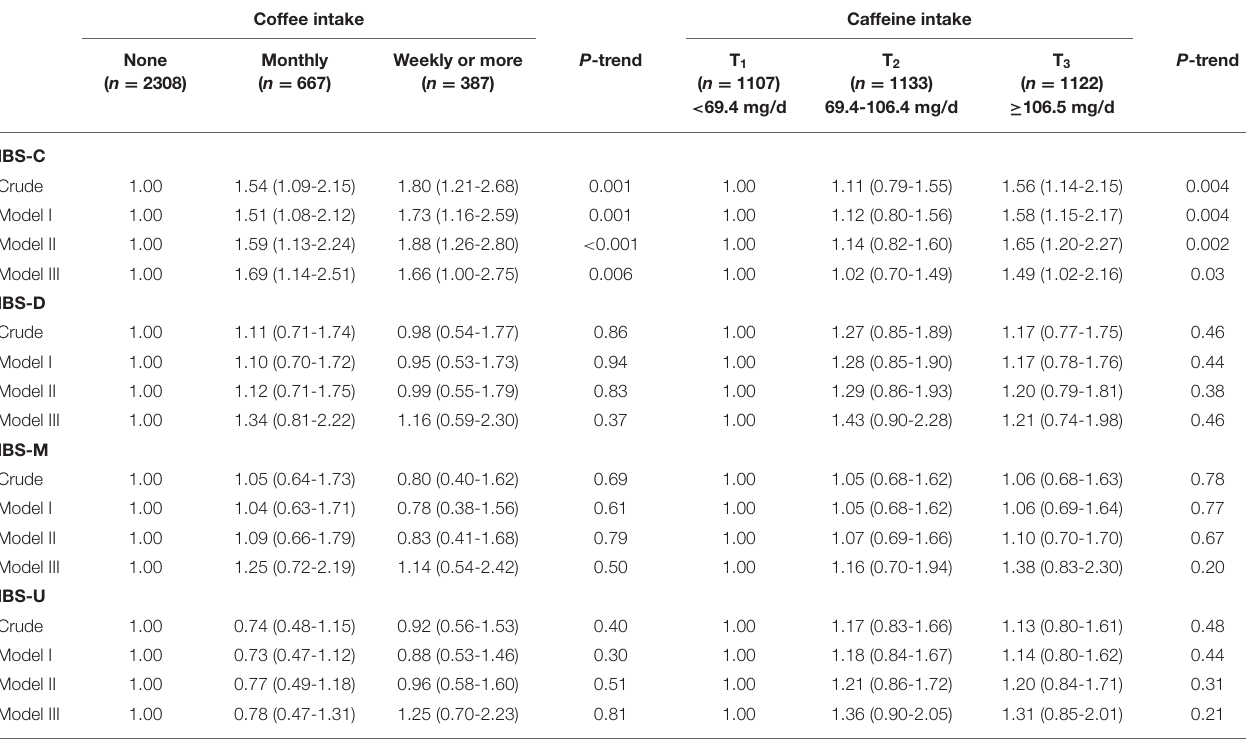
TABLE 4 | Crude and multivariable-adjusted ORs and 95% CIs for IBS subtypes across categories of coffee and caffeine intake a . Coffee